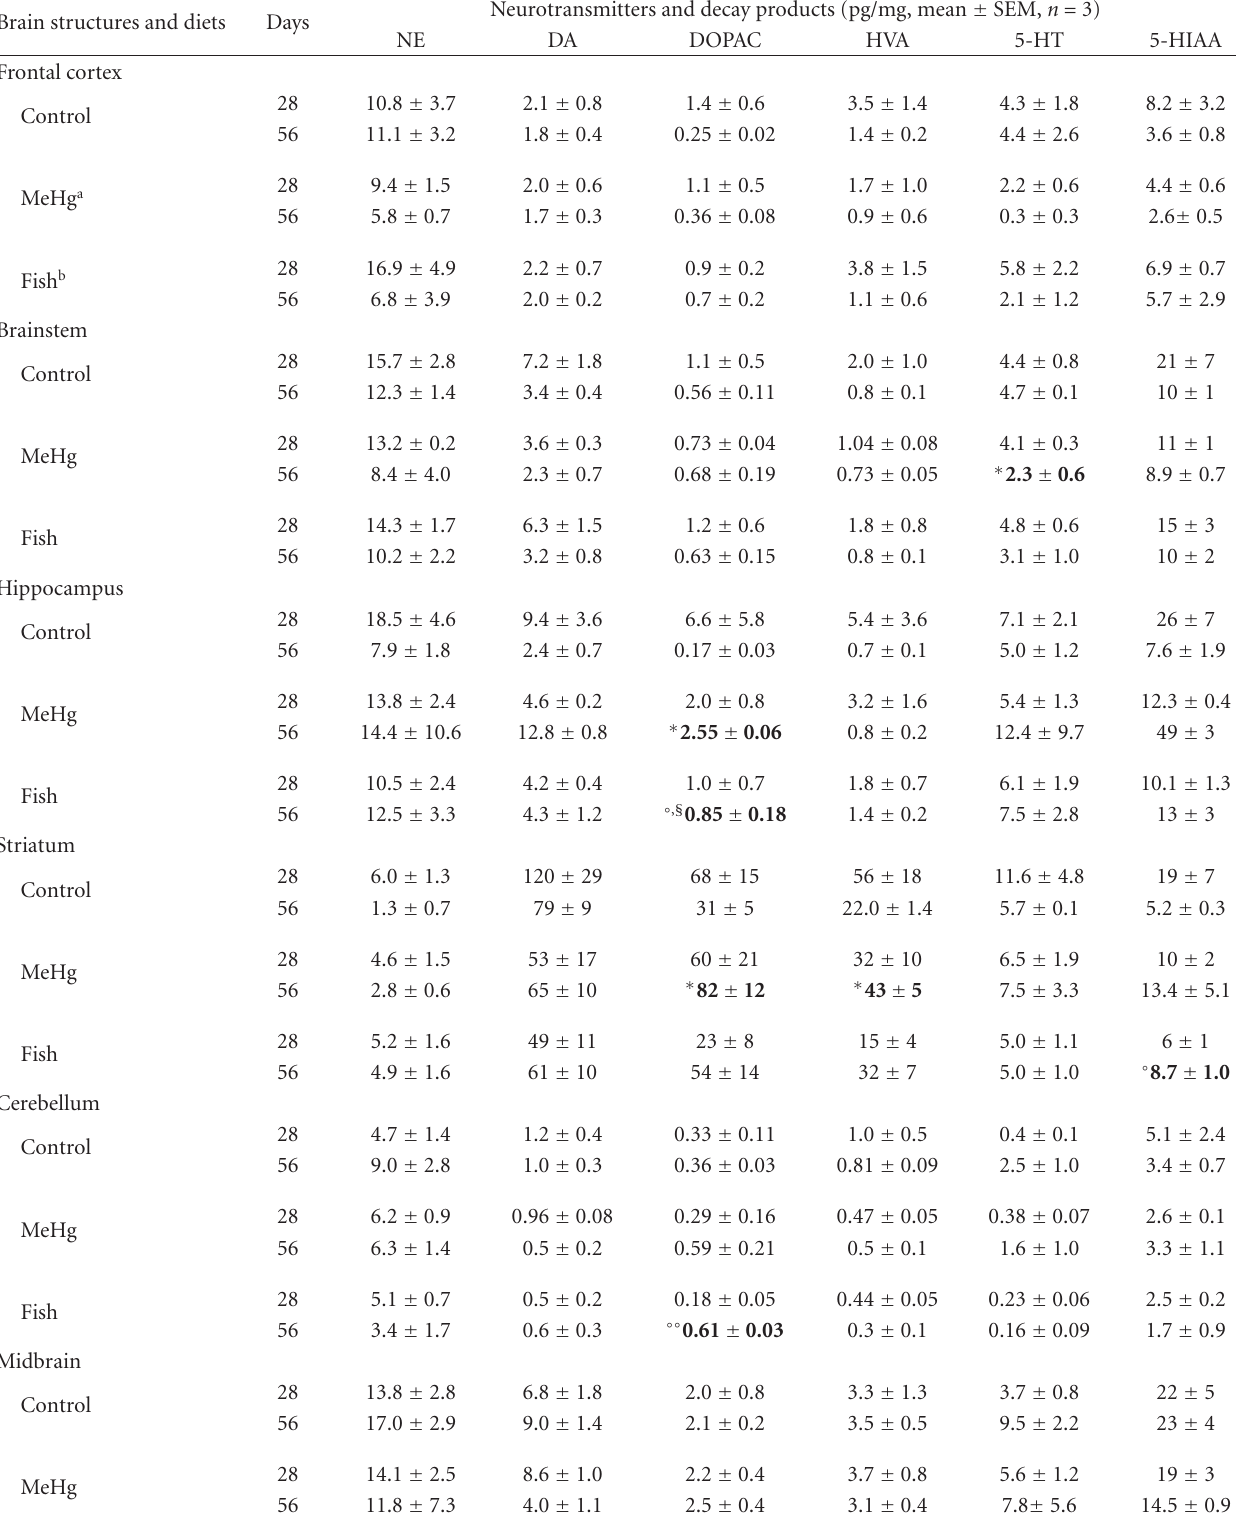
Table 5: Neurotransmitter levels and associated decay products in brain structures of mice fed MeHg- and fish-containing diets. Brain structures and